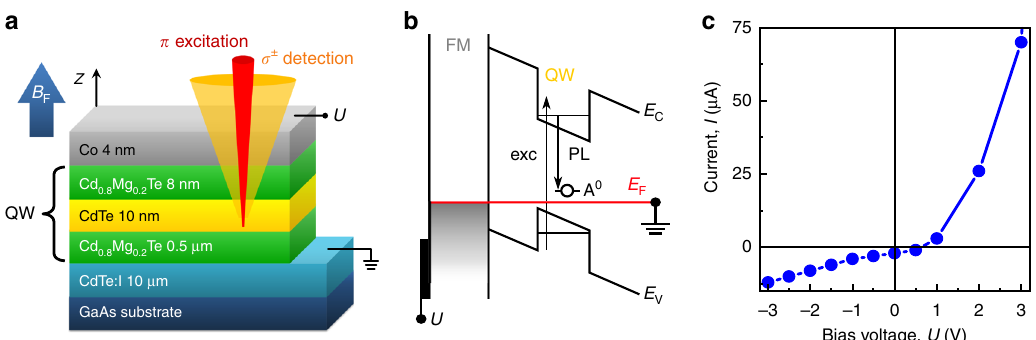
Fig. 1 Sample characterization. a Schematic device architecture and geometry of the cw experiment. b Schematic presentation of the band diagram at U = 0, where E V and E C denote the valence and conduction bands, respectively, and E F indicates the Fermi level. c Current – voltage characteristics I ( U )